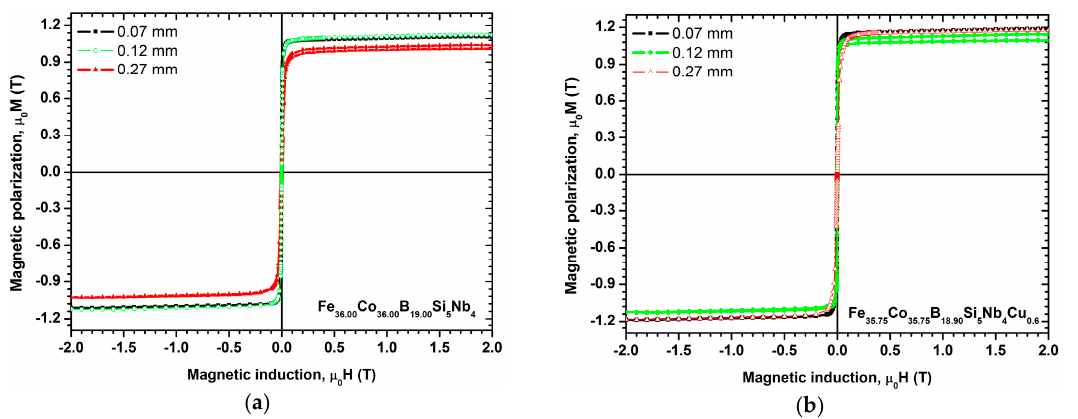
Figure 13. Room temperature magnetic hysteresis loops measured at a maximum magnetic induction of μ 0 H = 2 T for samples of ( a ) Fe 36.00 Co 36.00 B 19.00 Si 5 Nb 4 and ( b ) Fe 35.75 Co 35.75 B 18.90 Si 5 Nb 4 Cu 0.6 alloys in ribbon form with thicknesses of 0.07, 0.12, and 0.27 mm. Materials 2017 , 10 , 625